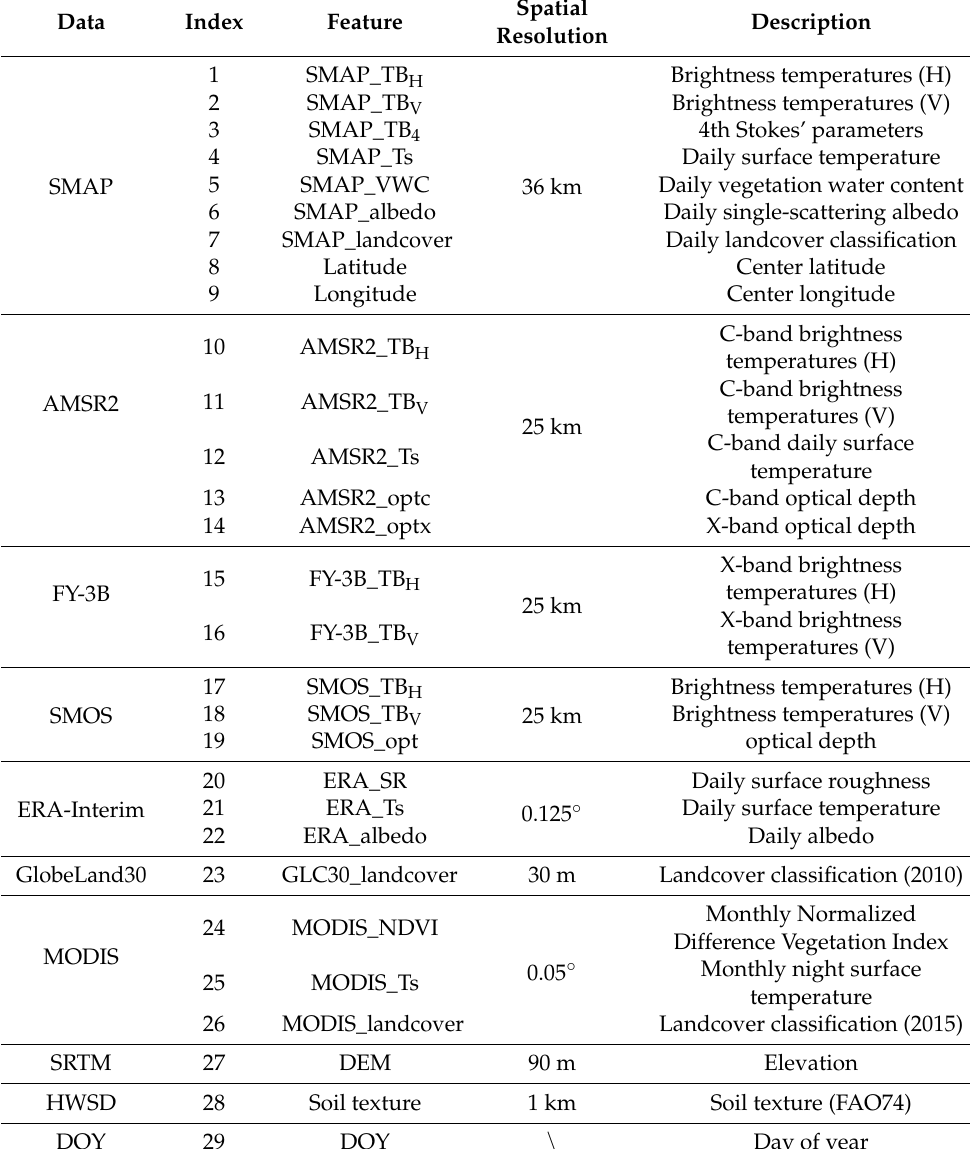
Table 3. Multi-source data considered for SM